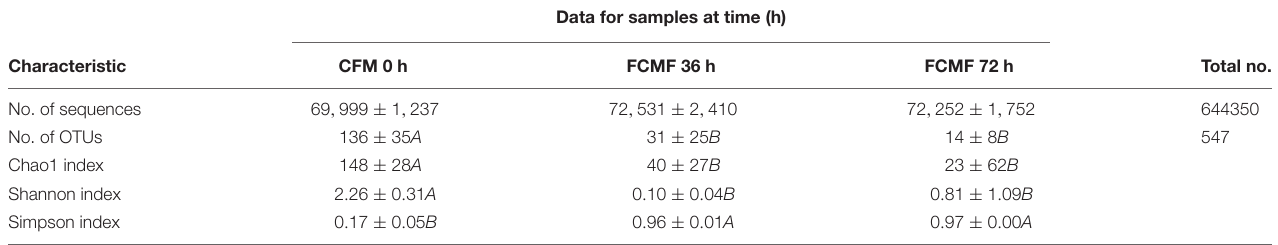
TABLE 6 | Characteristics of amplicon libraries in the fungal